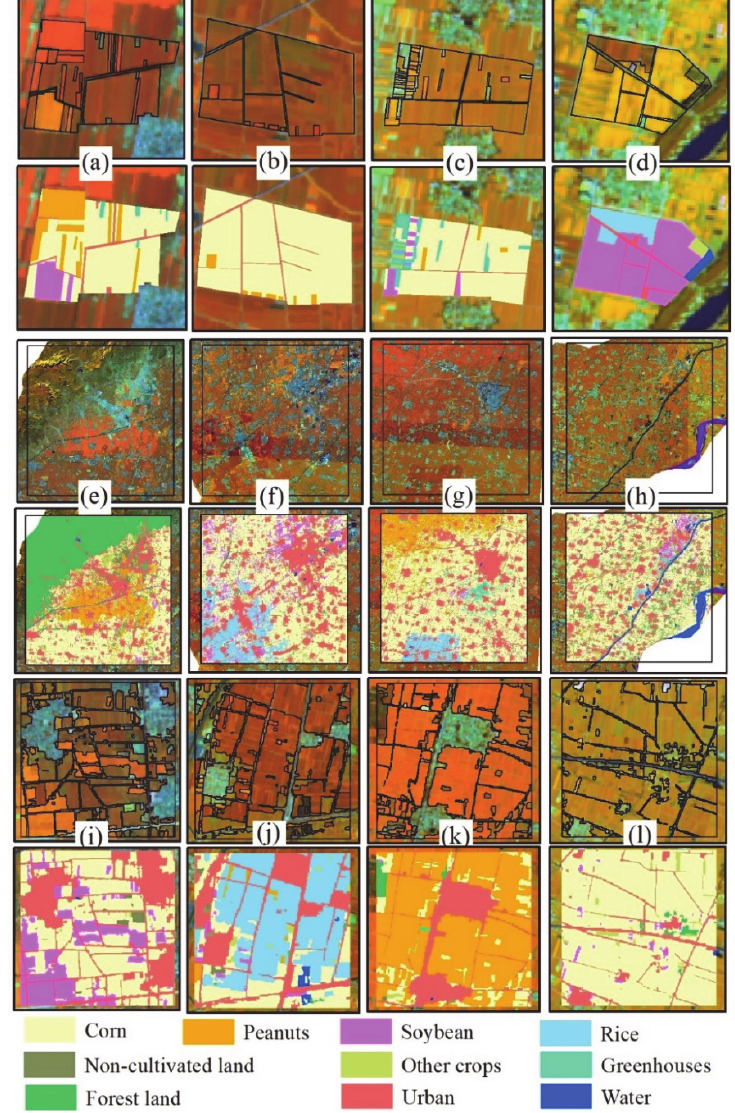
Figure 2. Sample plots, training data set, and validation sample plots. ( a ) Sample plot 1 (S1) in 2019; ( b ) sample plot 2 (S2) in 2020; ( c ) sample plot 4 (S4) in 2021; ( d ) sample plot 5 (S5) in 2021; ( e ) training data set of Site A in 2019; ( f ) training data set of Site B in 2019; ( g ) training data set of Site C in 2020; ( h ) training data set of Site D in 2020; ( i ) validation sample plot (VS1) in 2019; ( j ) validation sample plot (VS4) in 2020; ( k ) validation sample plot (VS3) in 2021; ( l ) validation sample plot (VS6) in 2021.